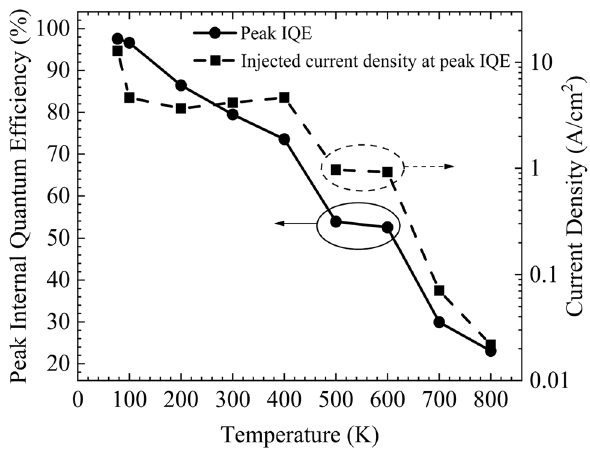
Figure 4. The peak IQE and the corresponding injected current density are extracted and plotted as a function of temperatures.